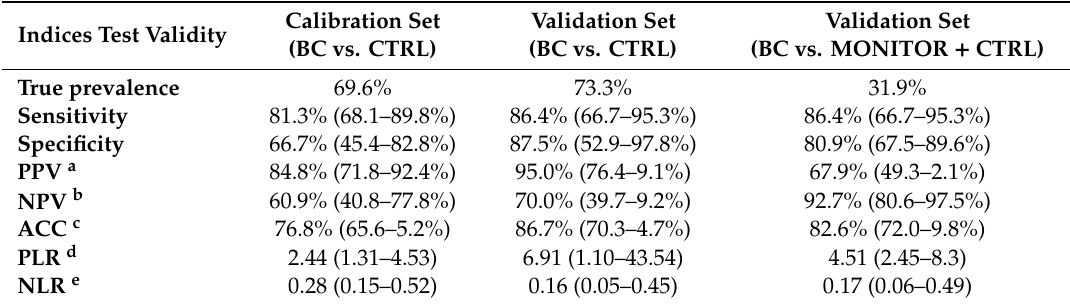
Figure 3. Discriminant analysis of BC, CTRL, and MONITOR samples. ( a ) Scores plot, PLS-DA predicted y values, and AUROC (area under receiver operating characteristic, ROC) for the first validation set (BC vs. CTRL); ( b ) Scores plot, PLS-DA predicted y values, and AUROC for the second validation set (BC vs. CTRL + MONITOR as control samples). Number of latent variables (LVs) = 3. Table 2. PLS-DA figures of merit for the discrimination between BC and control samples in the calibration and the two validation sets (LVs = 3).